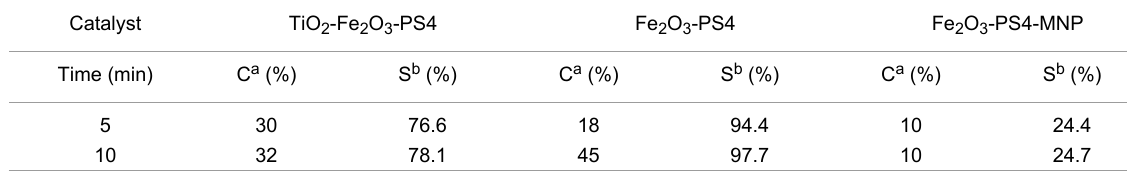
Table 5: Conversion and selectivity of the oxidation reaction of benzyl alcohol. Catalyst